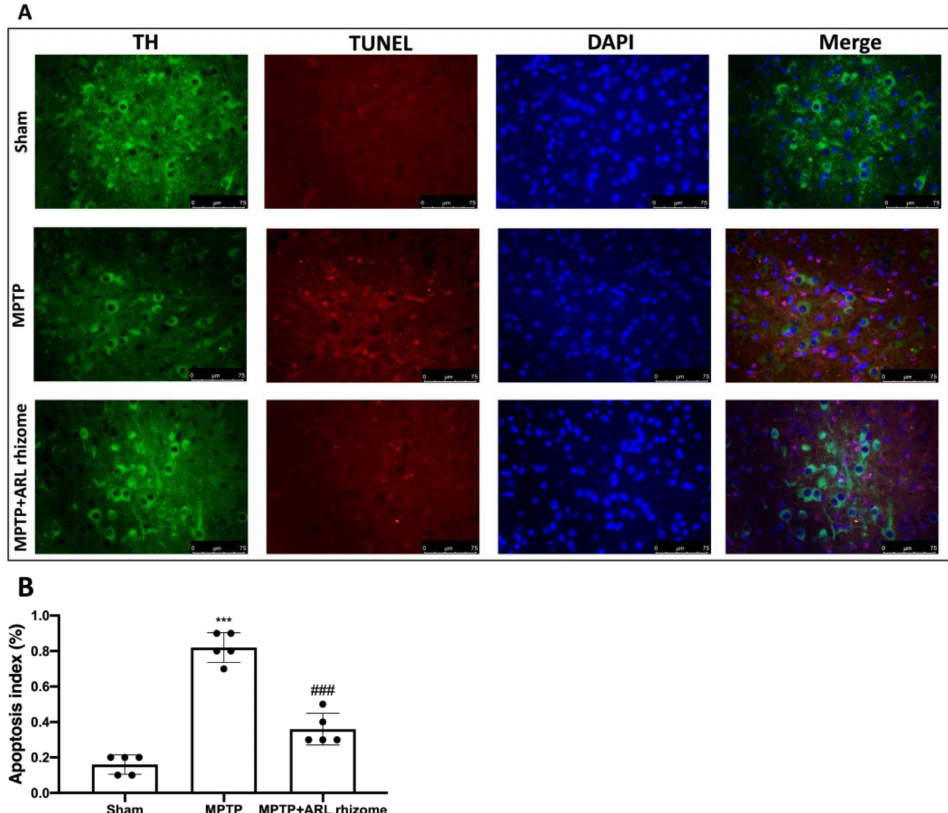
Figure 4. Effect of ARL rhizome on dopaminergic neurons death after MPTP-injection. Immunoflu- orescence for TH and TUNEL staining was evaluated in Sham; MPTP and MPTP + ARL rhizome ( A ). The results are expressed as % of apoptotic cells ( B ). The images are figurative of at least three independent experiments. Values = means ± SD of 5 animals in each group. *** p < 0.001 vs. Sham; ### p < 0.001 vs.